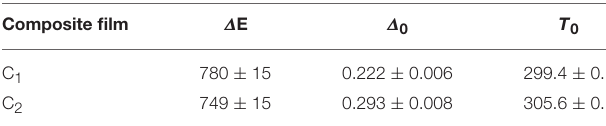
TABLE 2 | ∆ E (cm − 1 ), ∆ 0 and T 0 (K) values of the primary thermometer in C 1 and C 2 .